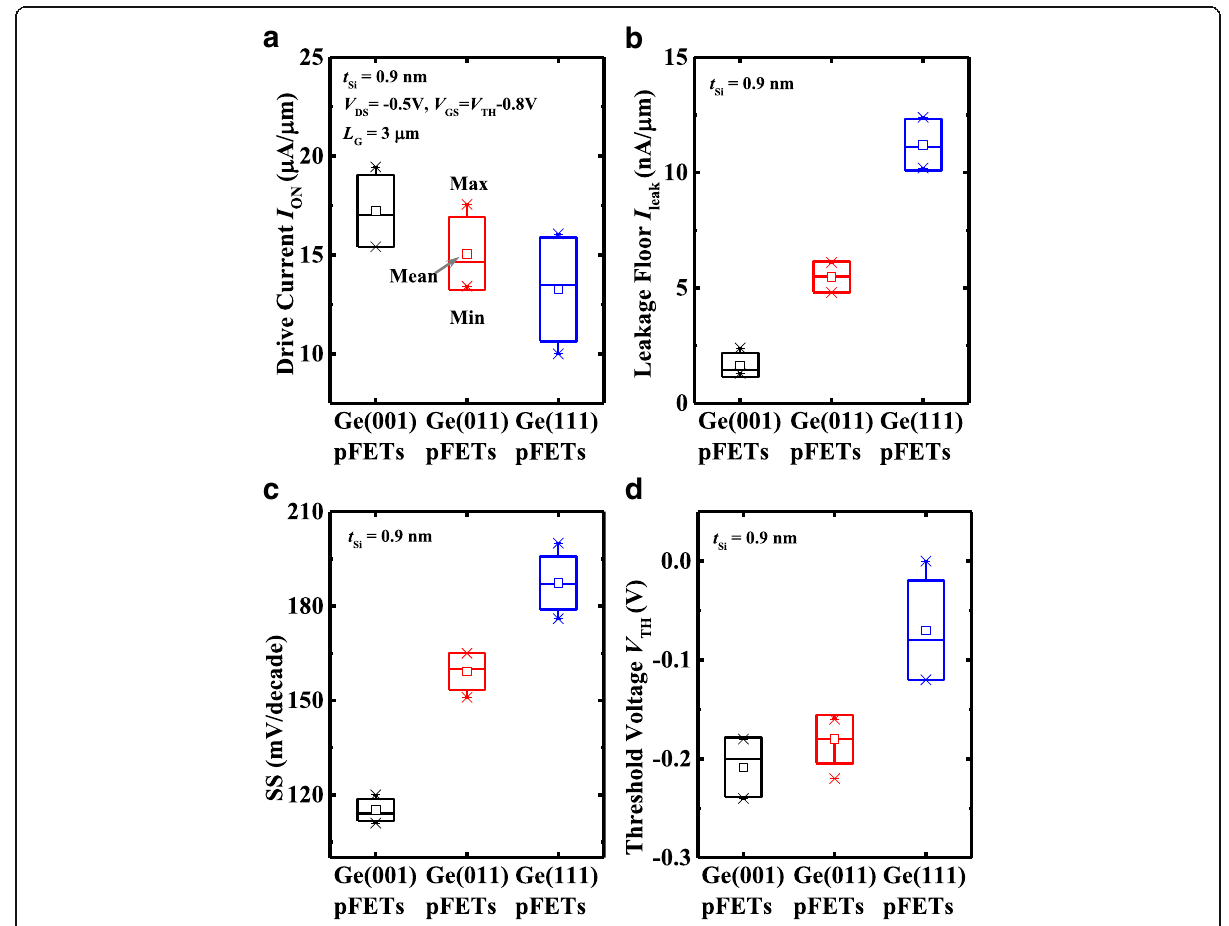
Fig. 4 Comparison of a I ON , b I leak , c SS, and d V TH for (001)-, (011)-, and (111)-oriented Ge pMOSFETs with a t Si of 0.9 nm